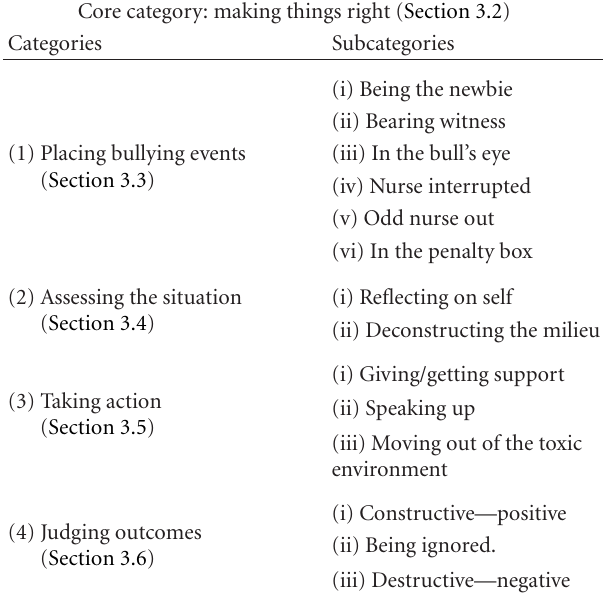
Table 1: Categories and subcategories for making things right (Section